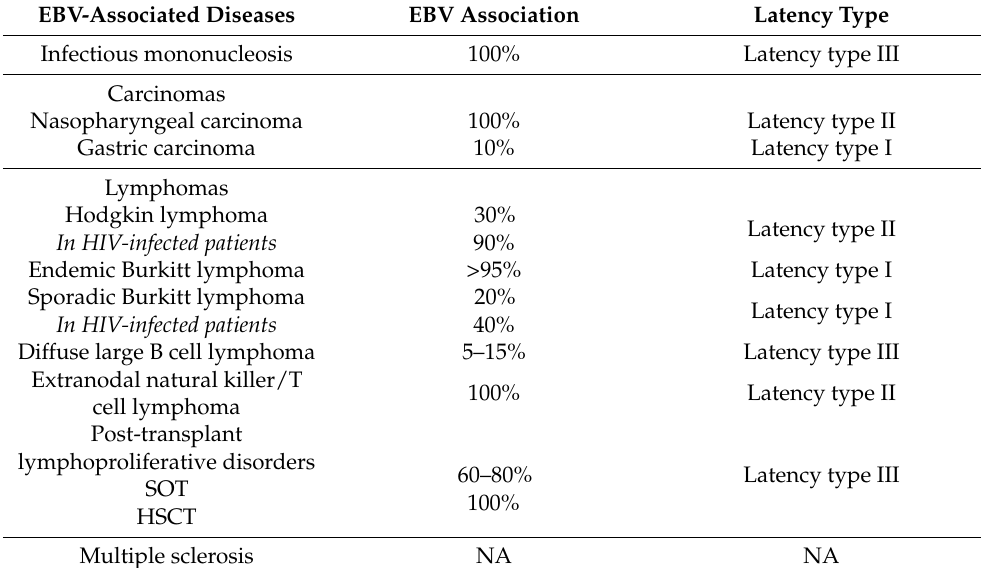
Table 1. Main Epstein–Barr virus (EBV)-associated